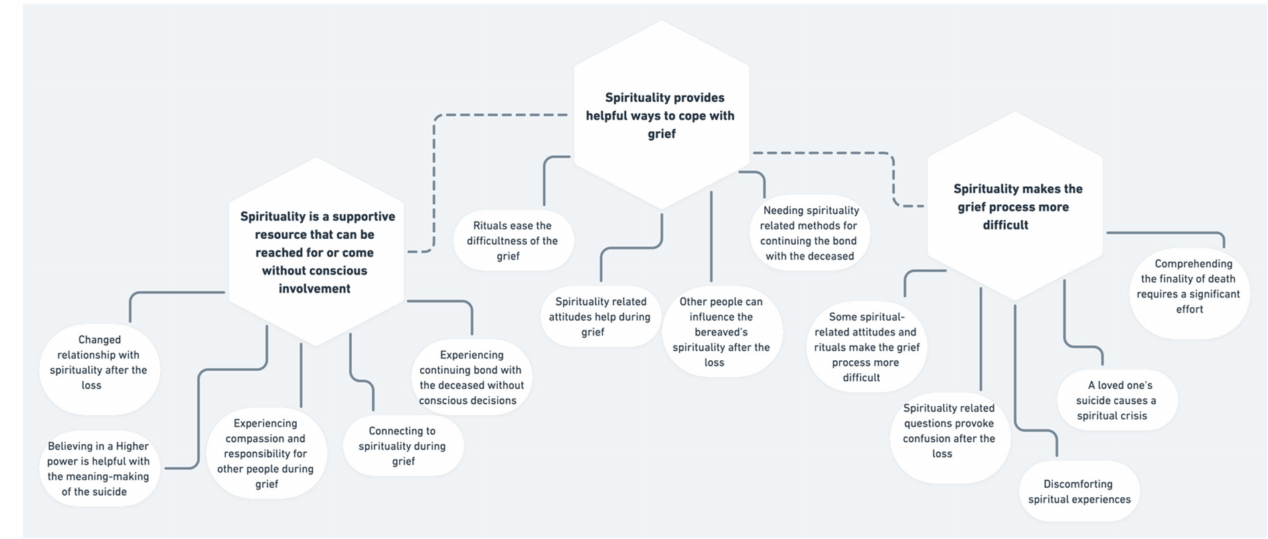
Figure 1. The thematic